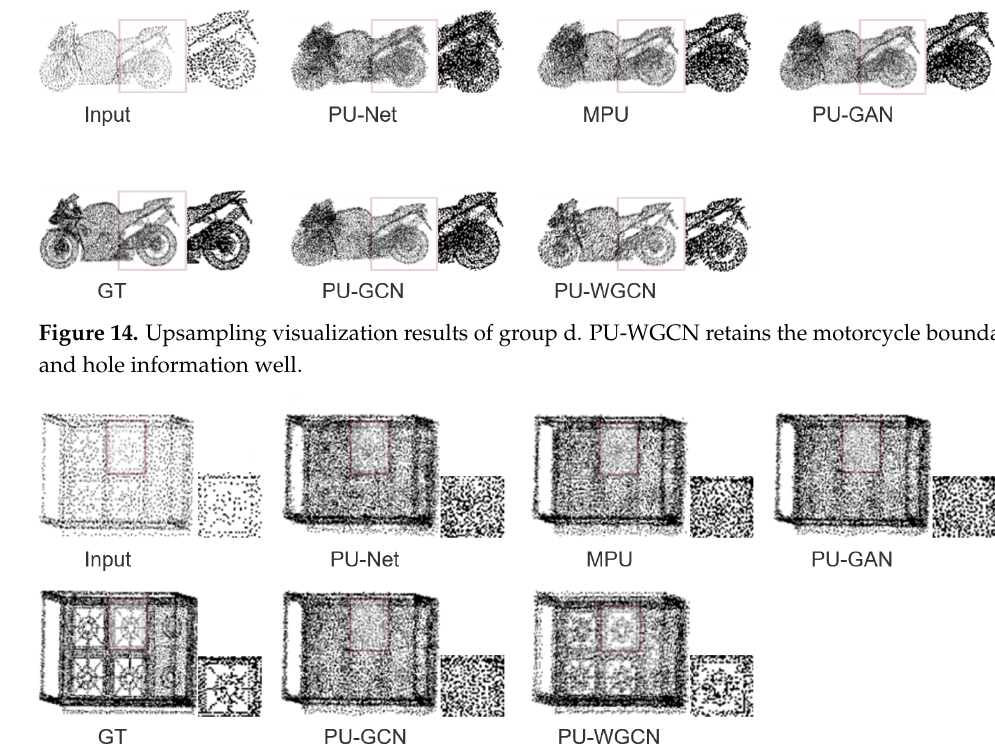
Figure 13. Upsampling visualization results of group c. PU-WGCN preserves the boundary and hole information of the chair well.